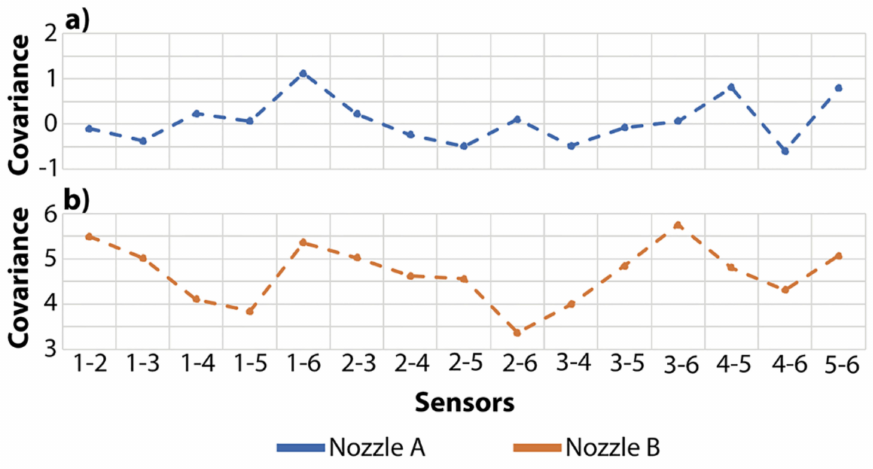
Figure 20. Covariances of bath level fluctuations. ( a ) Nozzle A with clogging. ( b ) Nozzle B with